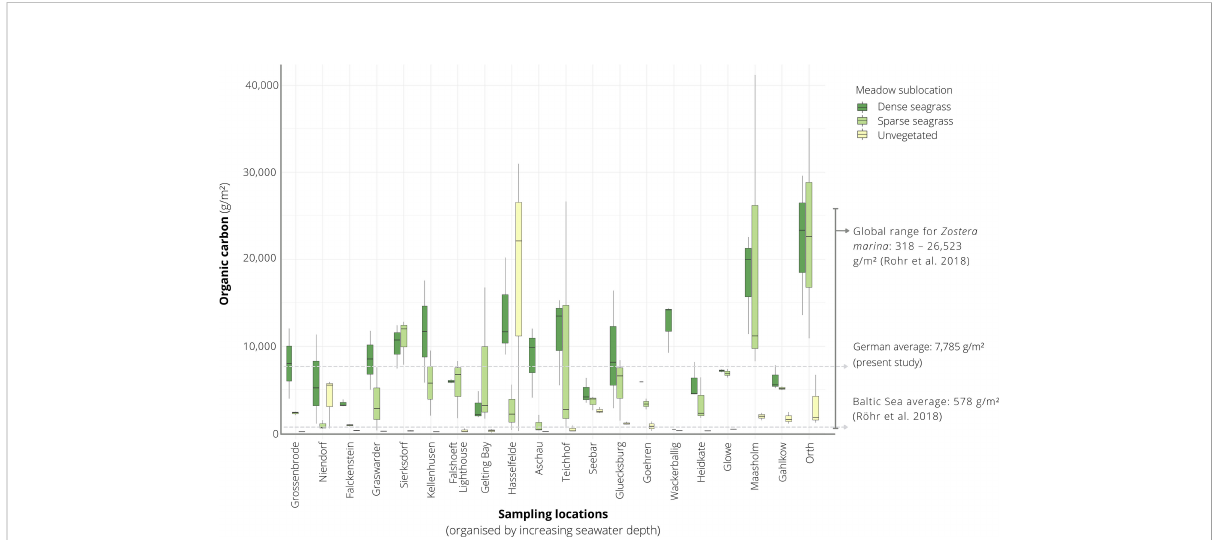
FIGURE 3 An overview of the organic carbon (C org ) stocks (integrated to 25 cm of sediment depth) across 20 sampling locations situated on the Baltic Sea coast of northern Germany. Sites are ordered by increasing seawater depth (left to right). Box and whiskers show the median as a line, fi rst and third quartiles as hinges, and the highest and lowest values within 1.5 times the interquartile range as